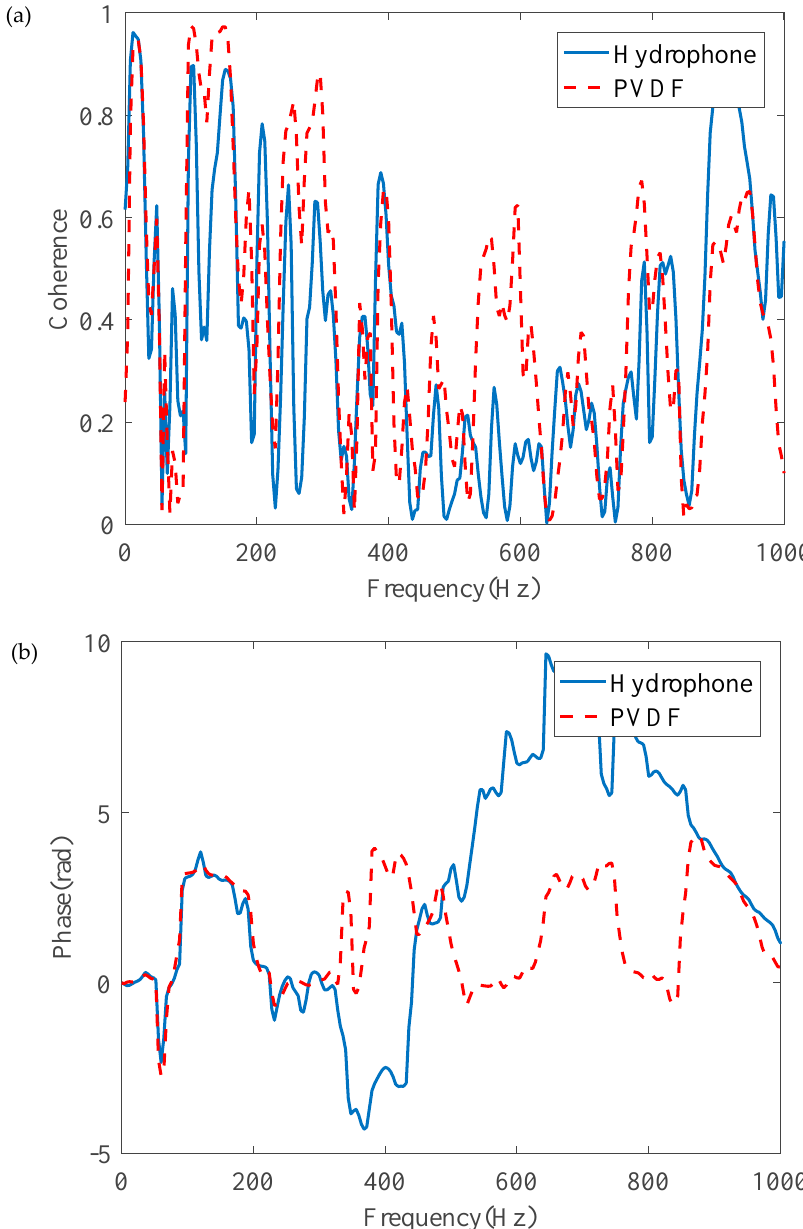
Figure 12. Frequency results of a pair of PVDF wire sensors and a hydrophone pair at the distances of 0.1 m and 0.9 m from the leak hole (in-air case): ( a ) coherence; ( b ) phase spectrum.